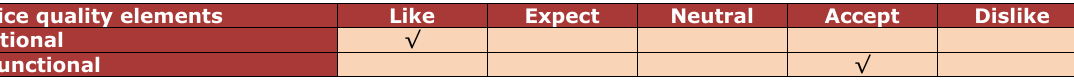
Table 2. Traditional Kano questionnaire